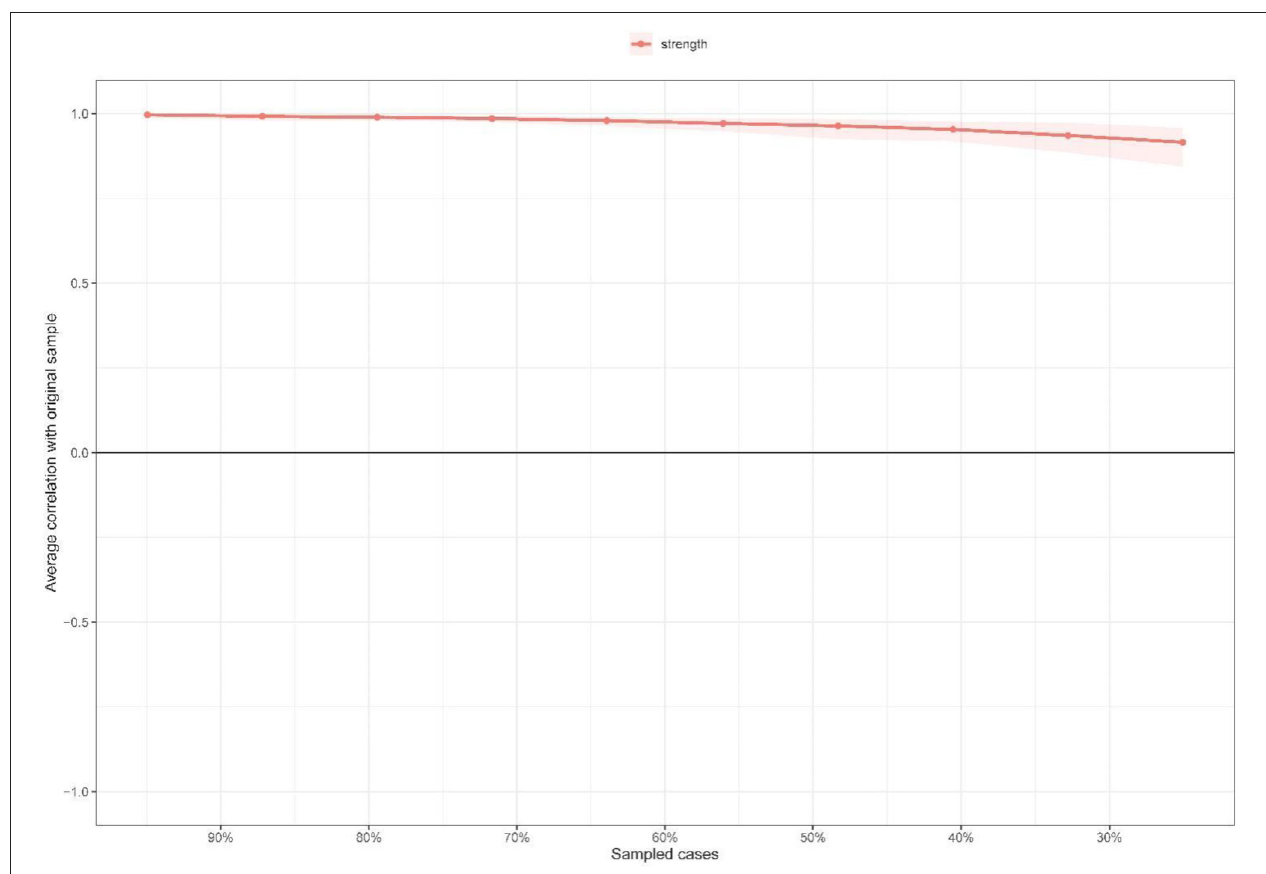
FIGURE 3 | Stability of centrality indices by case dropping subset bootstrap. The x-axis represents the percentage of cases of original sample used at each step. The y-axis represents the average of correlations between the centrality indices from the original network and the centrality indices from the networks that were re-estimated after dropping increasing percentages of cases. Each line indicates the correlations of strength and bridge strength, while areas indicate 95%